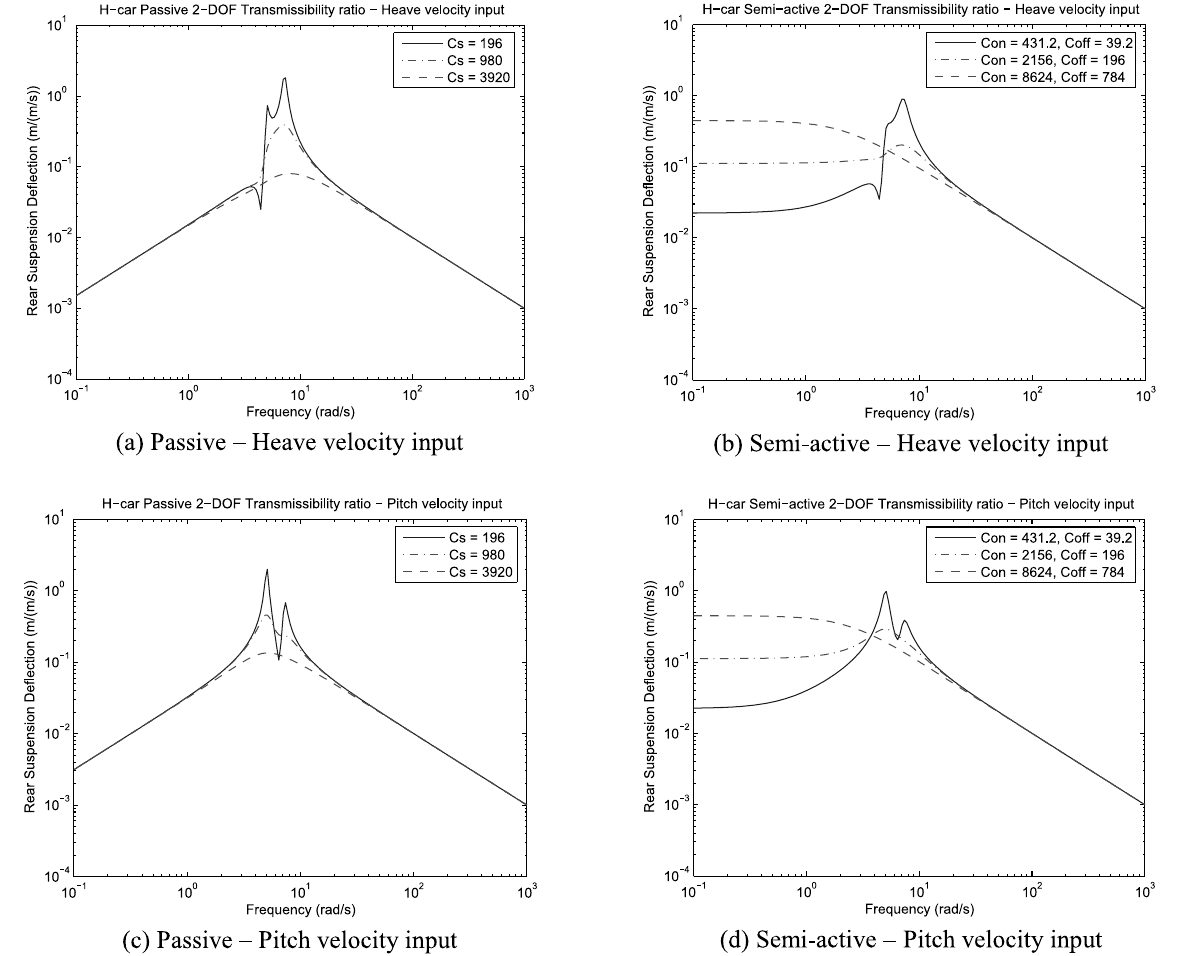
Fig. 6. Transmissibility ratio of rear suspension deflection for various damping